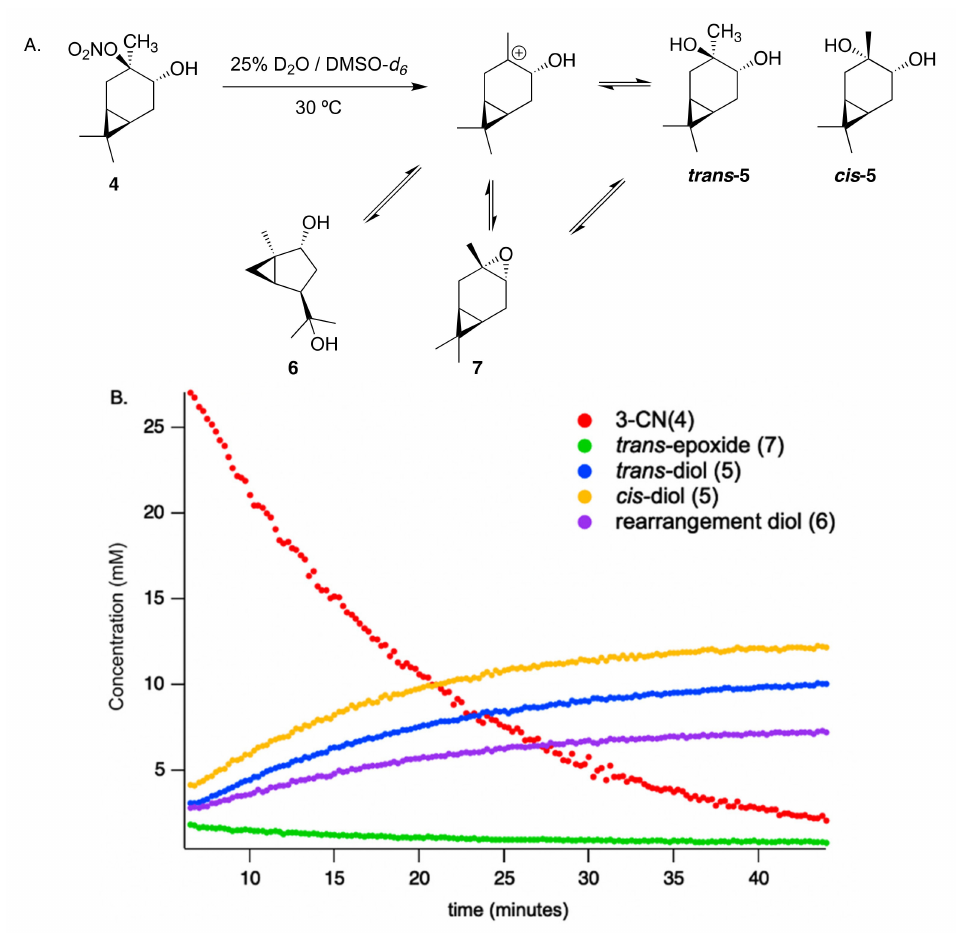
Figure 5. ( A ) Substitution and rearrangement reaction products from 3-CN ( 4 ); ( B ) time series for the conversion of 3-Car ( 4 ) and the formation of the major products in acidified 25% D 2 O/DMSO- d 6